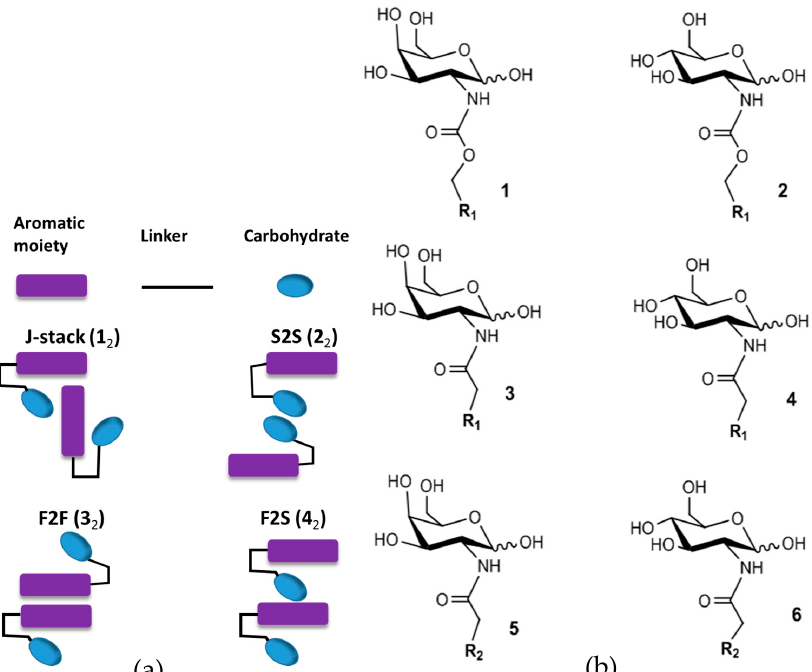
Figure 3. ( a ) Schematic representing dimer configurations of various amphiphilic systems ( 1 – 6 ). ( b ) Structures of the aromatic carbohydrate amphiphiles 1 – 6 containing different aromatic moieties (R 1 and R 2 ) and either a galactosamine or glucosamine residues. R 1 and R 2 represent fluorene and naphthalene residues, respectively. Redrawn from [90].